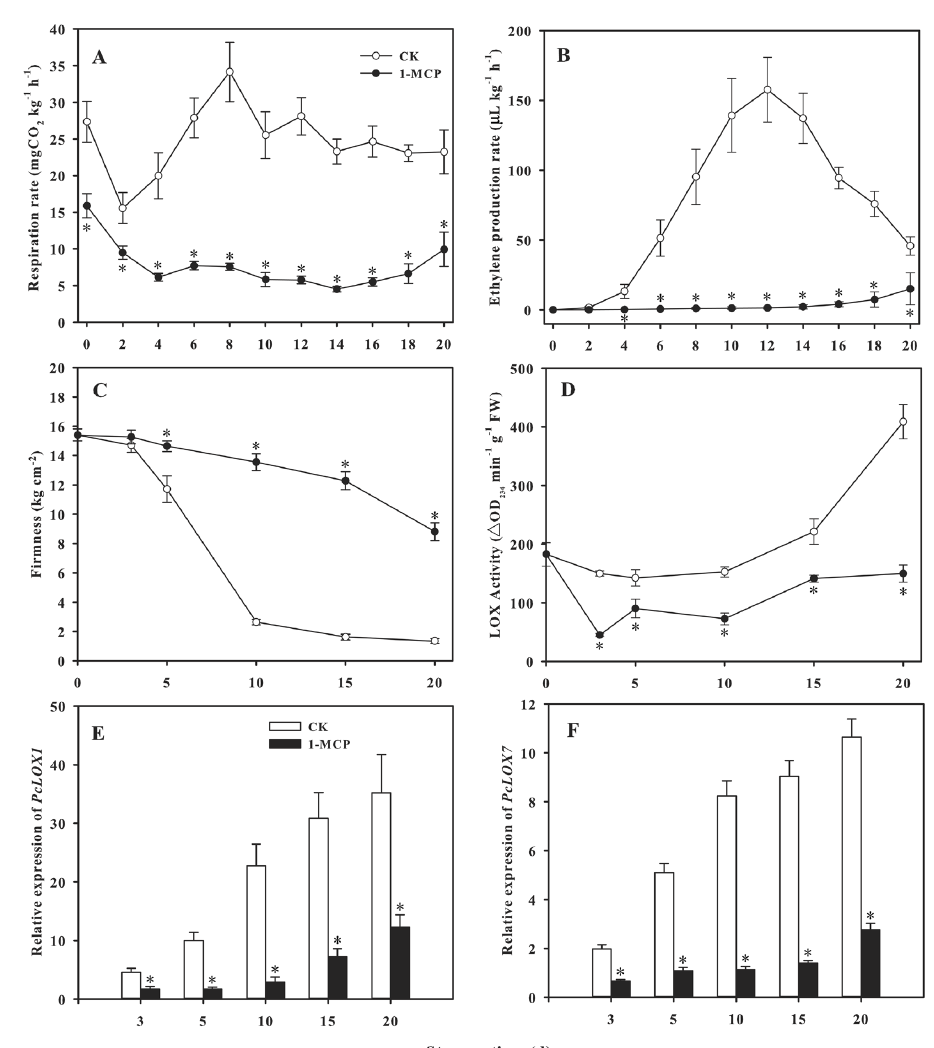
Fig. 3: LOX activity and gene expression in pulp during fruit softening in ambient temperature storage. (A) Respiration rate; (B) ethylene production rate; (C) firmness; (D) LOX activity; (E) and (F) expression of PcLOX1 and PcLOX7 genes. Data are the means ± SE of three replicates. The vertical bars represent the standard errors of the means. The ‘*’ represents a significant difference ( P <